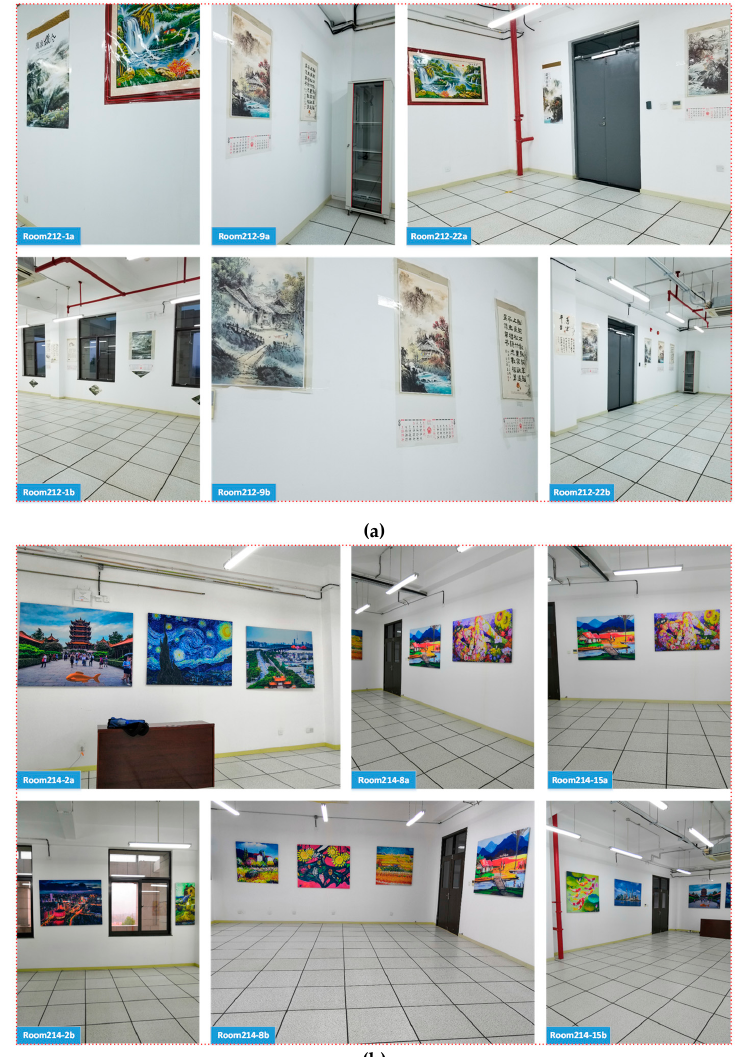
Figure 11. Positioning images: (a) images in Room 212 and (b) images in Room 214.